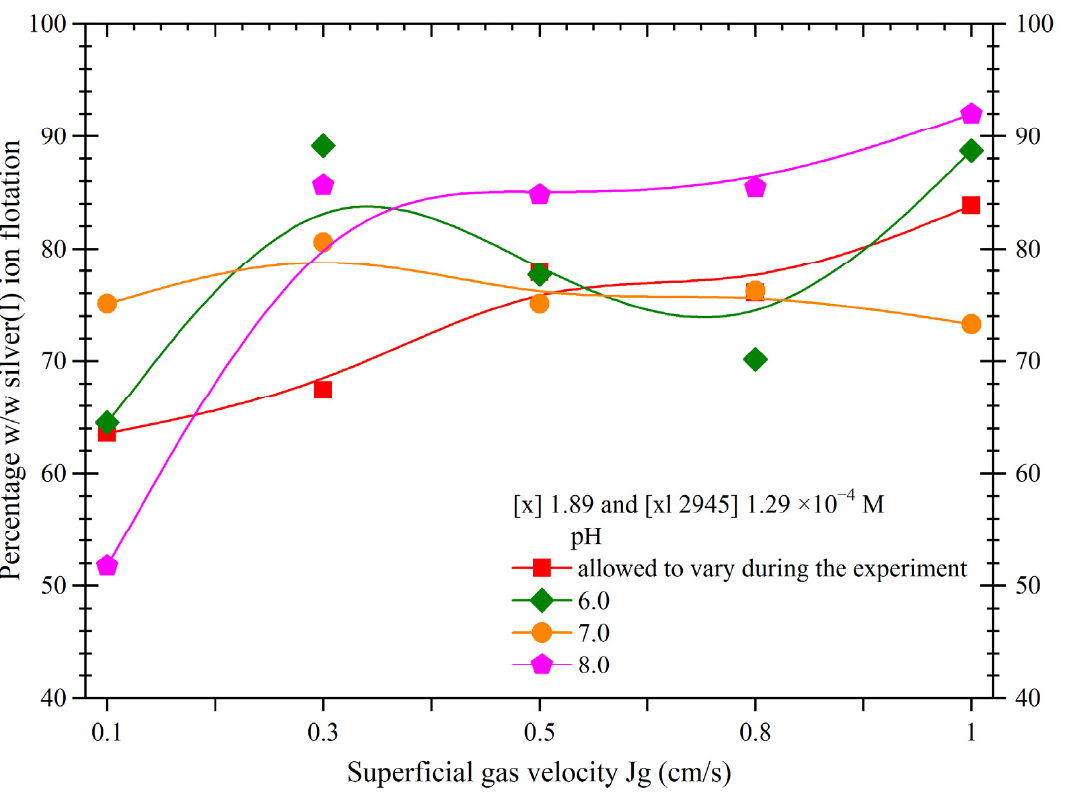
Figure 13. Percentage of w / w silver(I) recovery by ion flotation as function of superficial gas velocity, collector–promoter and promoter combinations Jl 0.19 cm/s, ceramic sparger fl at.